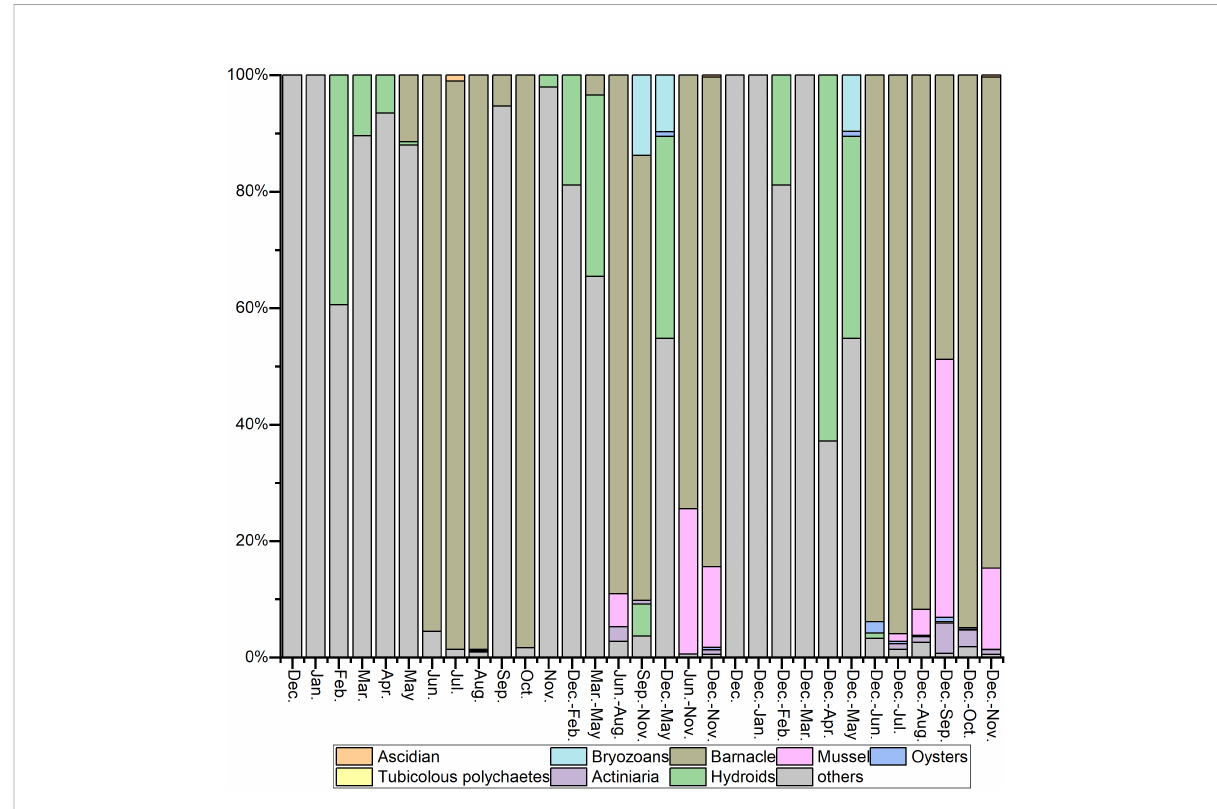
FIGURE 5 Biomass composition of the top test panels of MTPs and